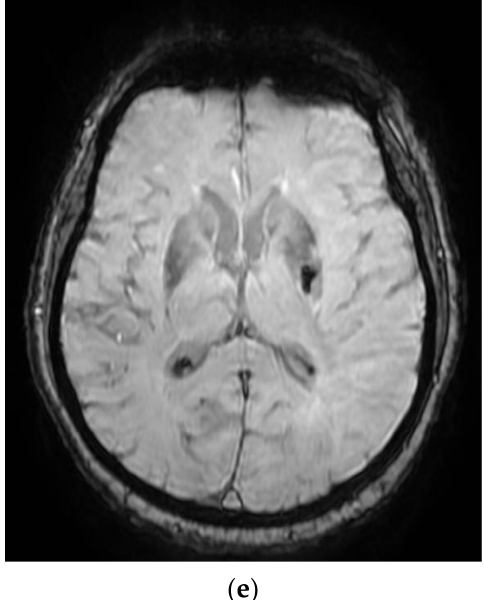
Figure 2. MRI images of the Case 2 patient shows extended foreshores, irregularly delimited, T2- FLAIR hyperintense ( a , b ), with restriction of marked diffusion ( c , d ), confirmed by a hypointense signal on the map of apparent diffusion ( d ), situated in the cortical–subcortical frontal–parietal– occipital and left insular part, with capsular and lenticular extension. Centimetric intralesional focal signal point SWAN sequence was associated in the left lenticular nucleus ( e ). These characteristics are suggestive of acute ischemic stroke on the left superficial and profound Sylvian territory, and on the superficial territories of the border between the median cerebral artery/posterior cerebral artery and medium cerebral artery/left anterior cerebral artery ( a – d ), with a small area of hemorrhagic transformation in the lenticular nucleus ( e ).